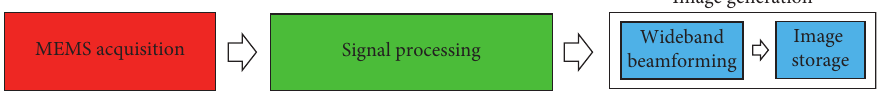
Figure 2: Software algorithms